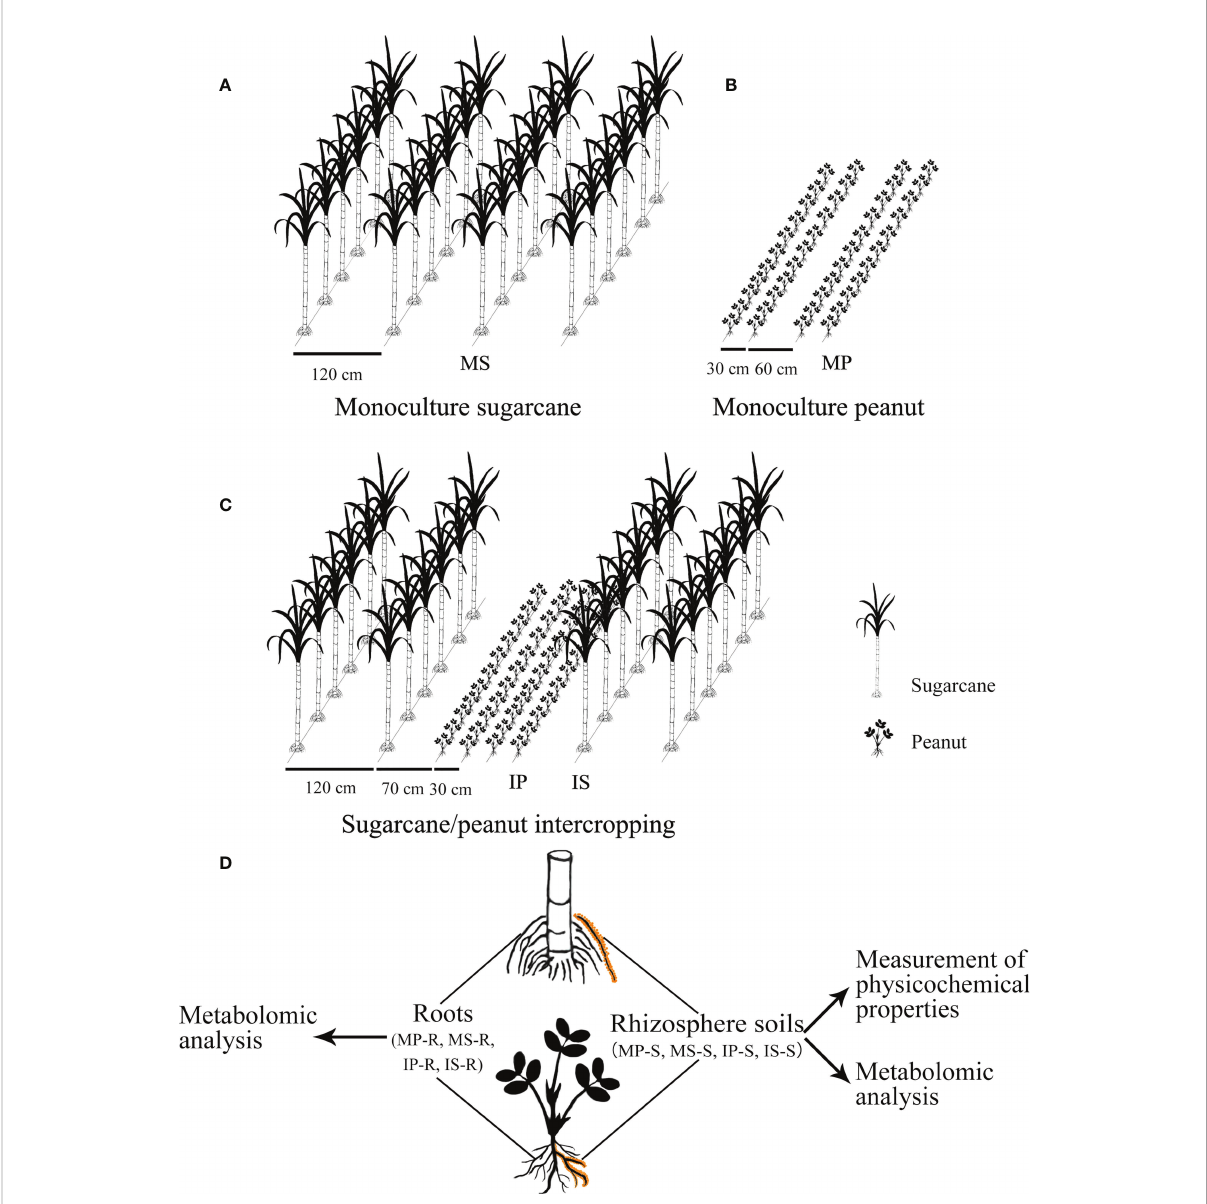
FIGURE 1 Experimental outline of the sugarcane and peanut fi eld. (A) Monoculture sugarcane; (B) monoculture peanut; (C) sugarcane/peanut intercropping; (D) schematic fi gure of sampling and research route. MP-S, MS-S, IP-S and IS-S represent rhizosphere soils of monoculture peanut, monoculture sugarcane, intercropping peanut and intercropping sugarcane, respectively. MP-R, MS-R, IP-R and IS-R represent the roots of monoculture peanut, monoculture sugarcane, intercropping peanut and intercropping sugarcane,